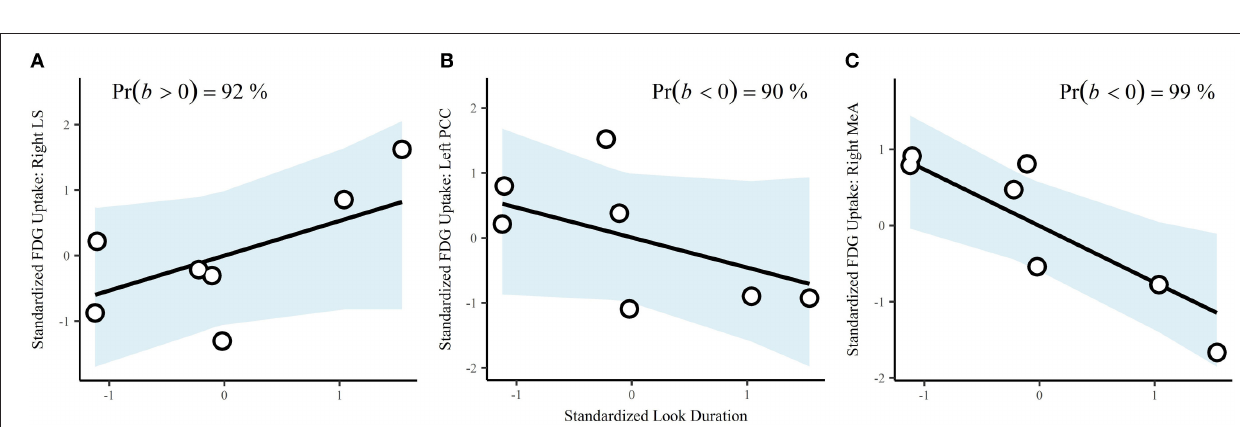
90%; Figure 4B ) and the right MeA ( b = − 0.74, CrI = [ − 0.99 to − 0.22], Pr( b < 0) = 99%; Figure 4C